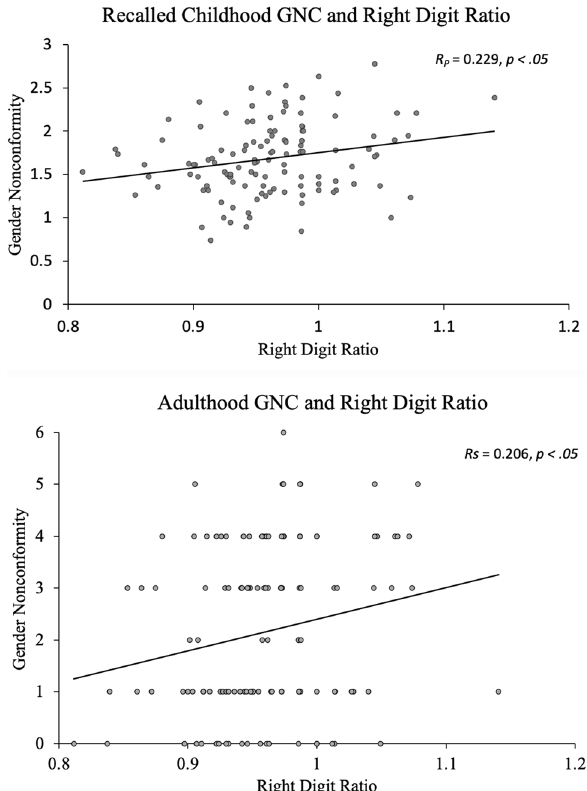
nonconformity scores. Similarly, a positive correlation between right digit ratios and Adulthood GNC indicates that a more male-typical digit ratio is associated with higher gender conformity. For consistency across measures, score on the Recalled Childhood GNC scale were subtracted by 5 and multiplied by negative 1 for graphical depiction of results; Thus, a higher score on both the Childhood and Adulthood GNC graphs indicates more gender